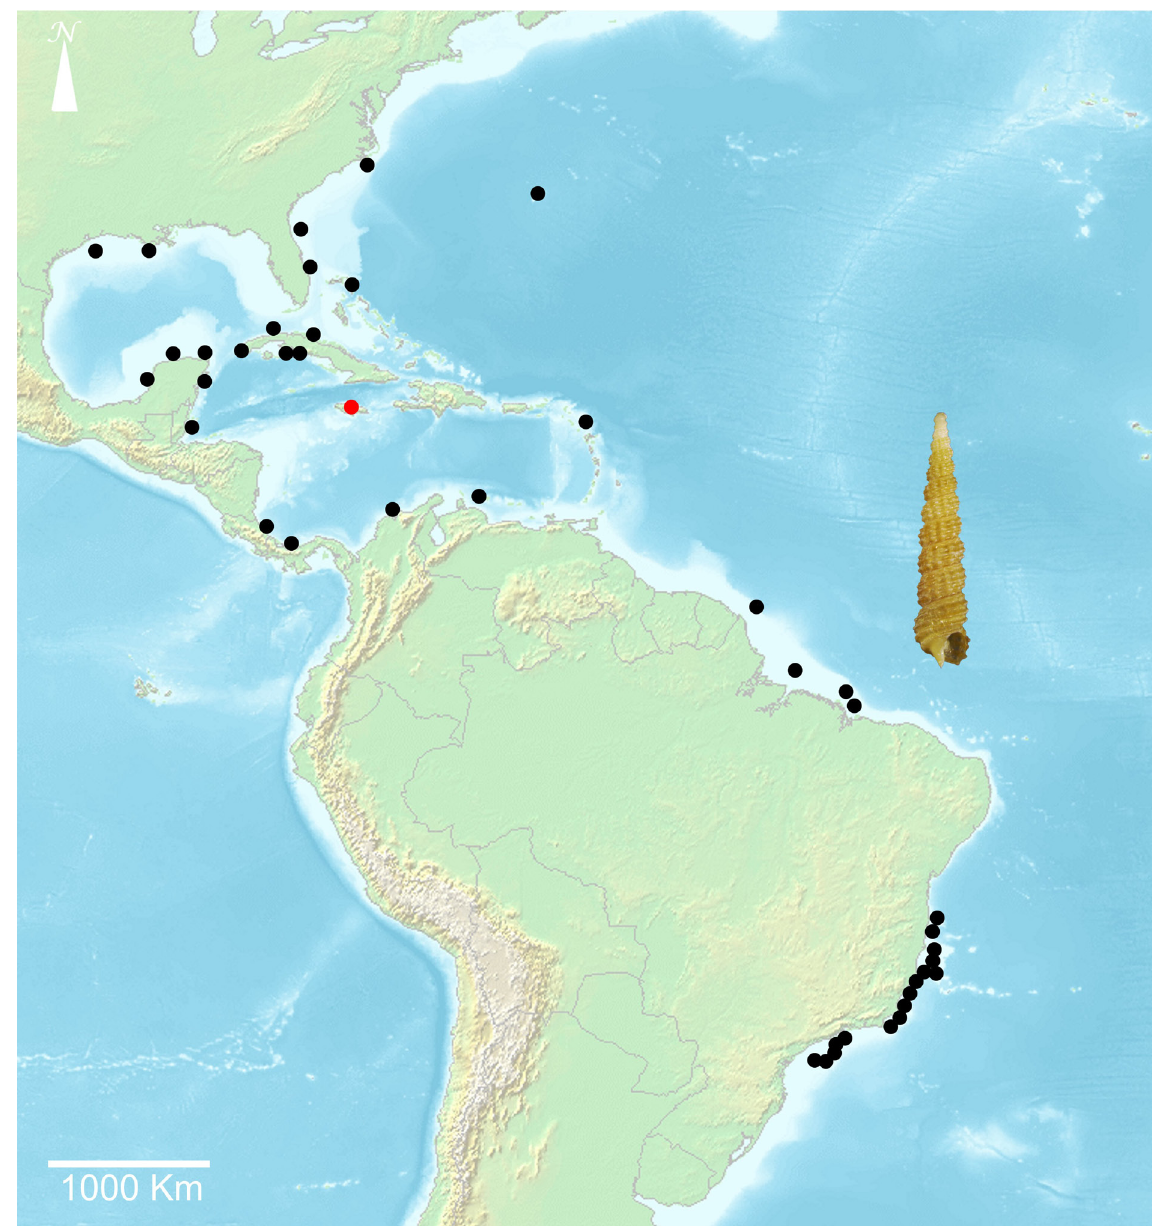
Fig. 26. Distribution map of Metaxia rugulosa (C.B. Adams, 1850); red circle = type